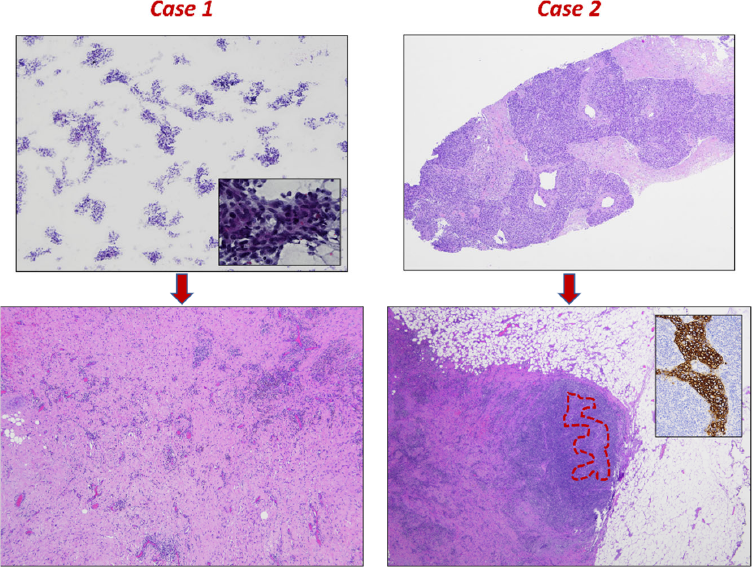
Figure 1. Fine-needle aspiration (top left, 2× magni fi cation, Papanicolaou stain) and biopsy (top right, 2× magni fi cation, hematoxylin & eosin stain) fi ndings. Malignant epithelial tumors with high-grade nuclear features, which are more clearly visible in the inset (40× magni fi cation, Papanicolaou stain). Post-operative histopathological samples show scar tissue with in fl ammation. There is no more of the tumor in the fi rst case (bo tt om left, 4× magni fi cation, hematoxylin & eosin stain), and just a small, residual, solid nest in the second case (bo tt om right, 2× magni fi cation, hematoxylin & eosin stain), which is highlighted in red and by CKAE1/AE3 stain (inset, 20× magni fi cation).